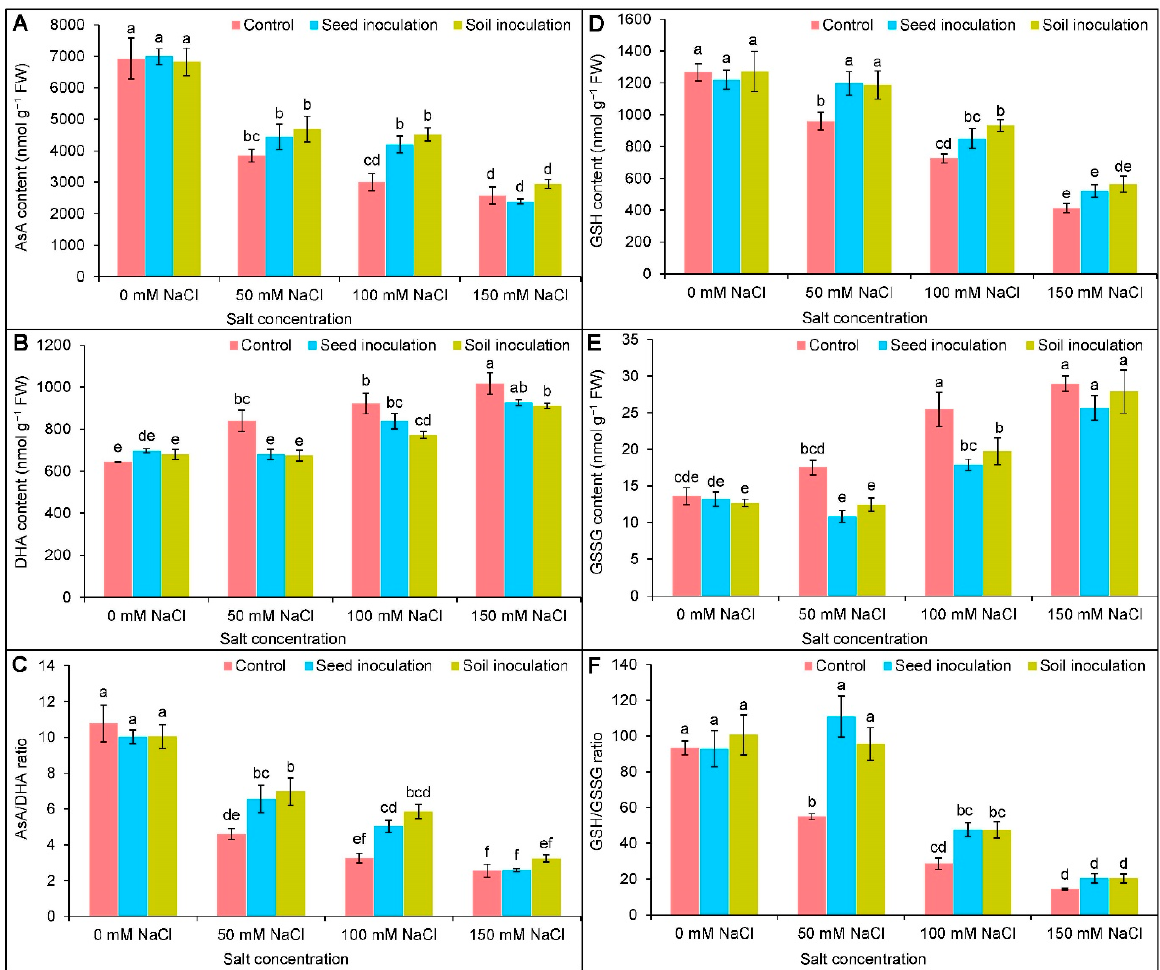
Figure 6. Effect of Bacillus subtilis in response to different concentrations of salt stress on the contents of AsA ( A ), DHA ( B ), AsA/DHA ratio ( C ), GSH ( D ), GSSG ( E ), and GSH/GSSG ( F ) of soybean ( Glycine max cv. BARI Soybean-5). Values in a column are mean ± SD. Different letters on each bar indicate significant differences among the treatment after applying a Tukey’s HSD test at p ≤ 0.05.